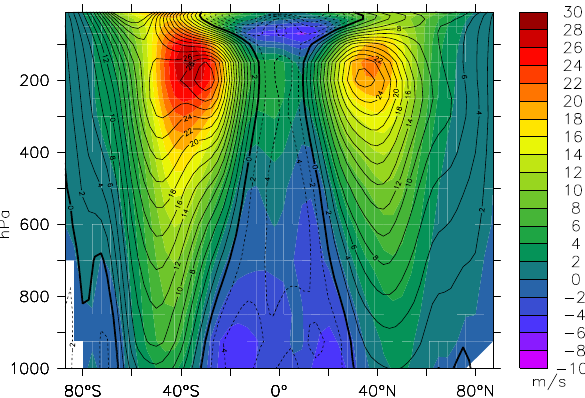
Fig. 13. Climatologically averaged zonal wind. The color denotes the wind speed in ms − 1 as calculated from simulation TRANS for the years 1968–1996, while the contour lines denote the wind speed calculated from the NCEP/NCAR Reanalysis 1 for the same years. The vertical axis is in